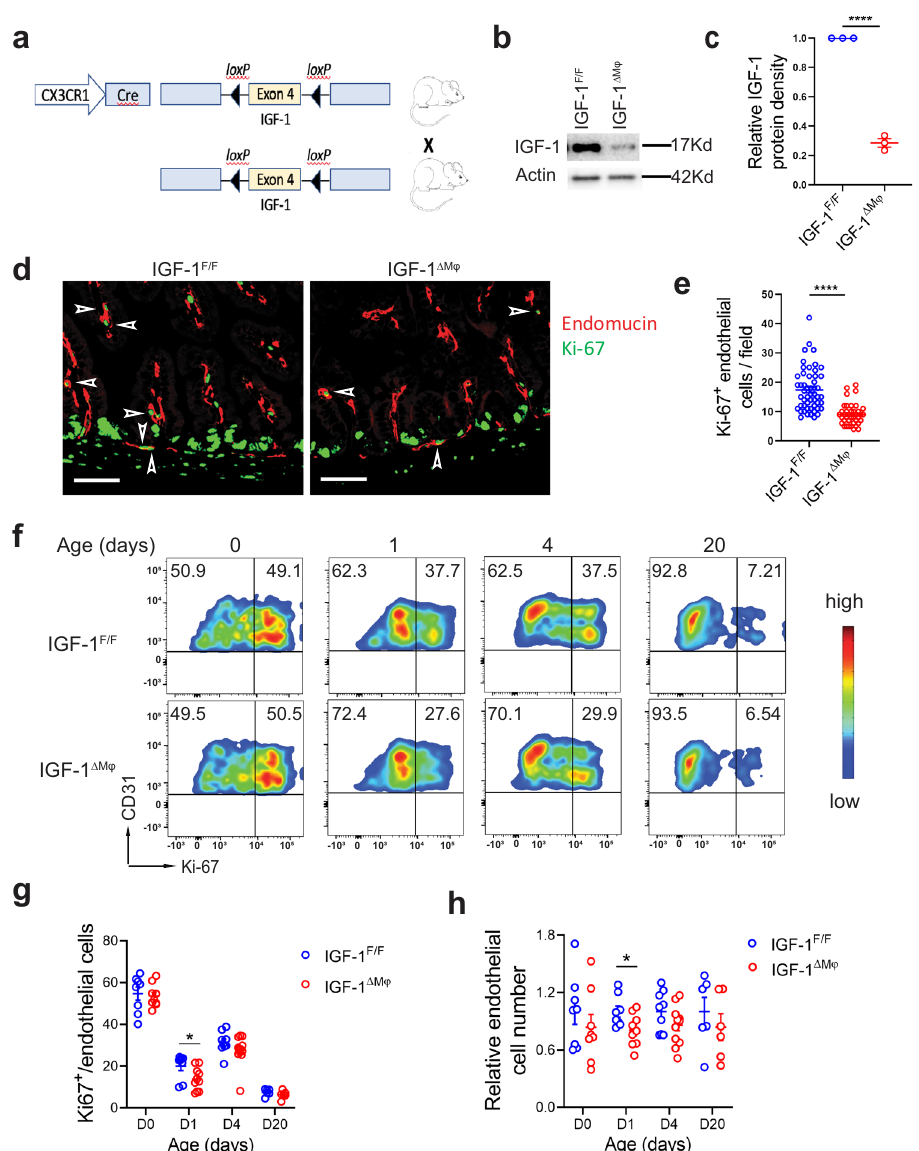
Fig. 5 Mice with IGF-1-de fi cient macrophages have decreased intestinal endothelial cell proliferation. a Breeding scheme for generating mice with IGF-1 suf fi cient and IGF-1-de fi cient macrophages. b , c IGF-1 protein is decreased in isolated CX3CR1 + cells from pups with IGF-de fi cient macrophages ( Igf-1 Δ M ϕ ) compared with IGF-1-suf fi cient littermates ( Igf-1 f/f ). For each group and in each experiment, intestines from 8 to 10 pups were pooled together to obtain enough cells for western blot analysis. b Western blot image of one experiment. c The experiment was repeated twice, and band density was quanti fi ed (mean ± SEM, n = 3 /group). d , e Tissue sections from 24-hour-old Igf-1 Δ M ϕ pups ( n = 6) or IGF-1-suf fi cient pups ( n = 8) were stained for Ki-67 (green) and endomucin (red). d Typical image is shown, scale bar: 50 μ m. e Average proliferating endothelial cells (Ki-67 + endomucin + ) per ×20 fi eld in the intestinal villi (see arrows in d ) were counted from 3 to 4 fi eld images per sample. Each dot indicates the number from one image. f – h Isolated small intestinal LP cells from D0, D1, D4, D20 IGF-1-suf fi cient or Igf-1 Δ M ϕ pups were gated on single/live CD31 + CD45 − cells and analyzed for CD31 and Ki-67. f Typical fl ow cytometry images are shown. g The graph represents the percentage of proliferating (Ki-67 + ) endothelial cells at different ages in the intestine of IGF-1-suf fi cient or Igf-1 Δ M ϕ pups (mean ± SEM). h Endothelial cell number relative to the isolated total cell number per intestine, which is subsequently normalized to Igf-1 f/f group, is shown here (mean ± SEM), n = 6 – 9/group ( g , h , see dots in panels and Source Data fi le for exact n number). P values were calculated using two-sided Student ’ s t tests ( c , e ) or multiple t tests ( g , h ). * p < 0.05, ** p < 0.01, *** p < 0.001, **** p < 0.0001. Source data are provided as a Source Data fi